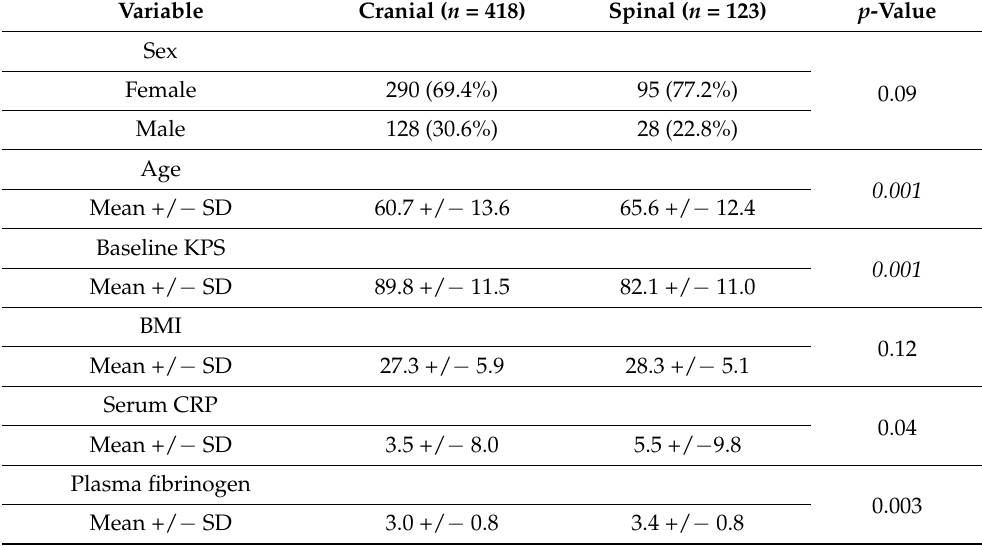
Table 1. Patient characteristics among the groups of WHO grade 1 and 2 meningioma ( n = 541). Statistical analysis was performed using independent t -test and Pearson ’ s chi-squared test (two- sided).